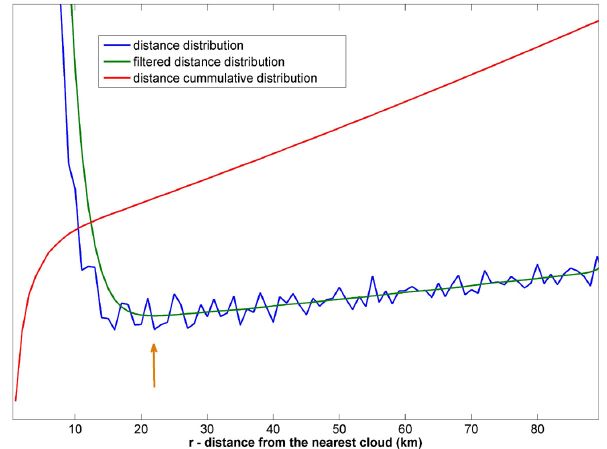
Fig. 2. Analysis of an observed cloud field, including the distance distribution dA(r)/dr (blue line, normalized), the filtered distance distribution function (green line, normalized), the distance cumu- lative distribution A(r) (red line, normalized), and the transition point, identified by the minimum of the filtered distance distribution function, and defining the field distance parameter (marked with an orange arrow).